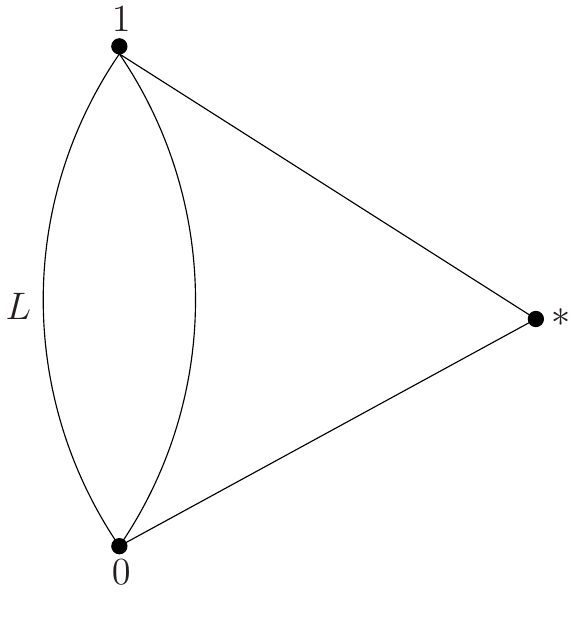
Figure 1. Extension of the lattice order